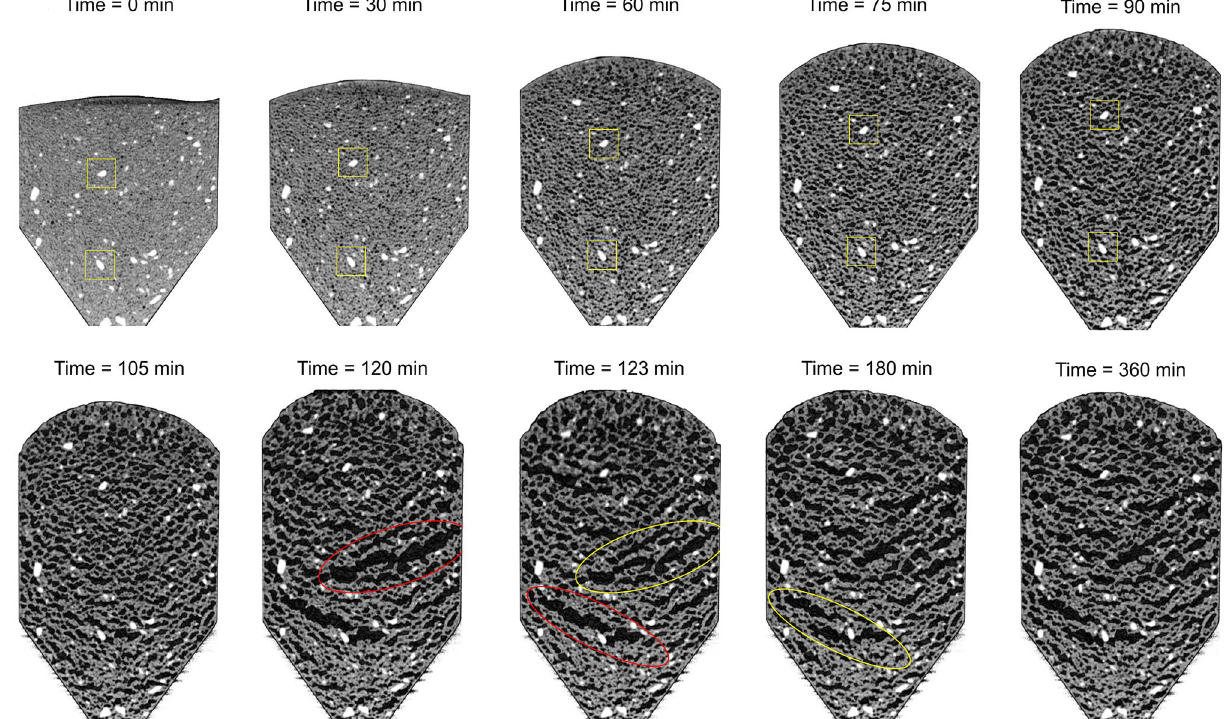
Figure 7. Time-lapse CT images during gas bubble formation and evolution in a cement–water–aluminium– bentonite specimen (at constant pressure—open). Mixture: water–cement ratio μ WC = M W /M C = 100%, aluminum mass ratio μ AC = M A /M C = 4%, and bentonite mass ratio μ BC = M B /M C = 8%, and aluminum chip mean size d 50 = 0.04